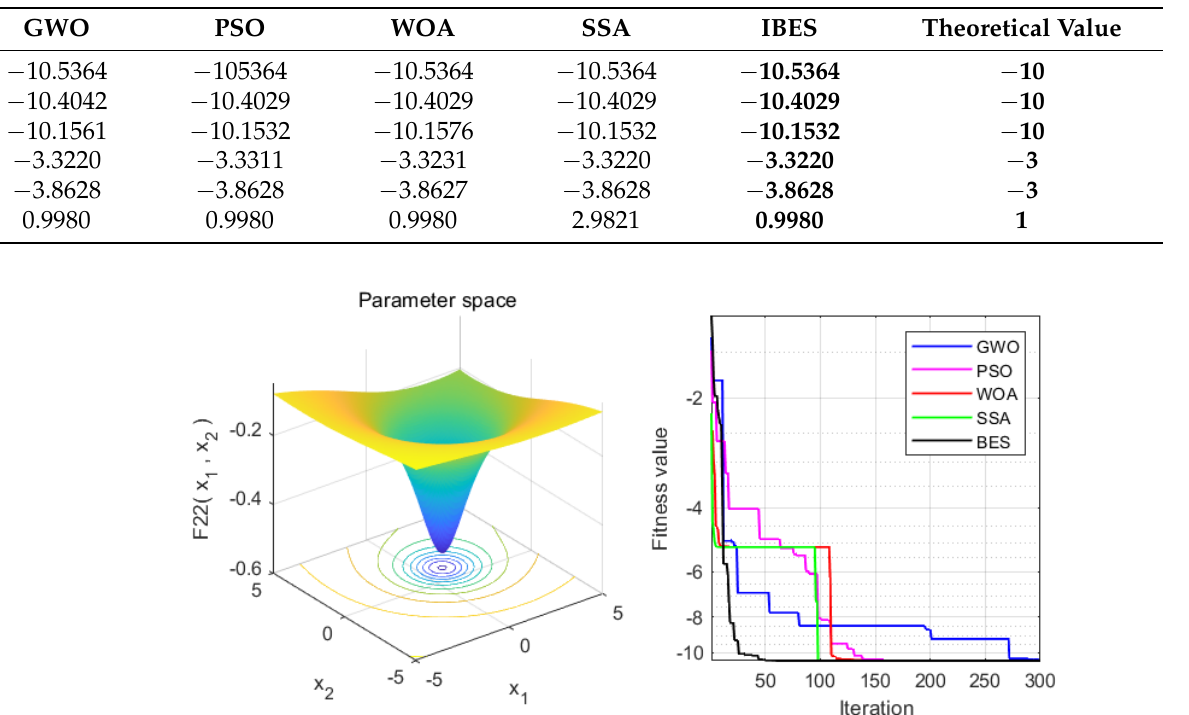
Figure 3. The result of